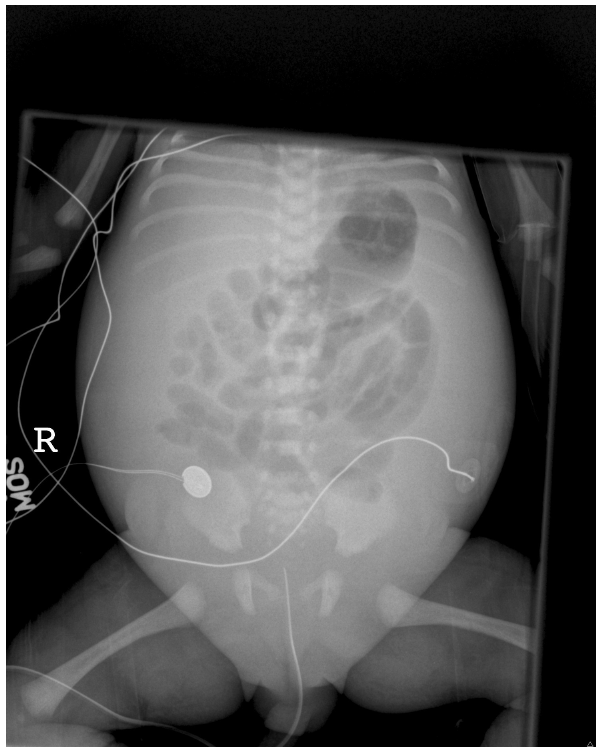
FIGURE 3. An abdominal radiograph demonstrating abdominal urinary ascites as a result of the elevated pressure in the urinary tract and calyceal